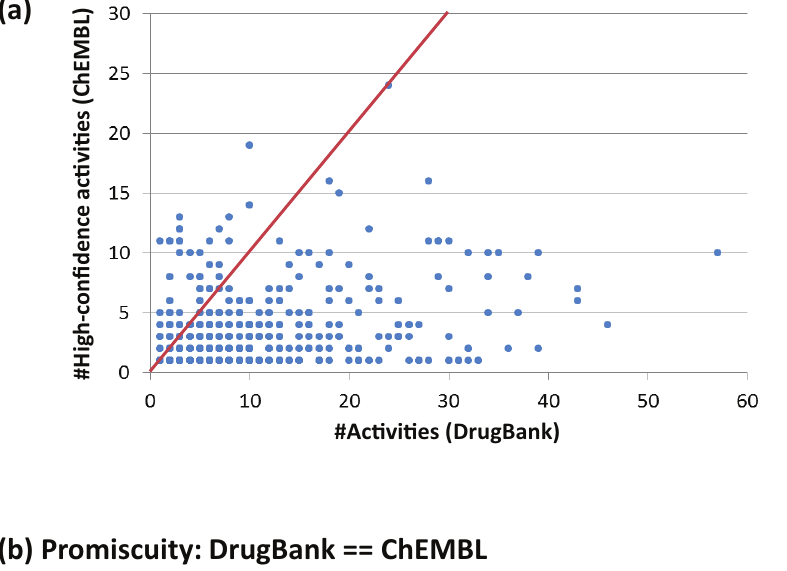
(b) Promiscuity: DrugBank == ChEMBL